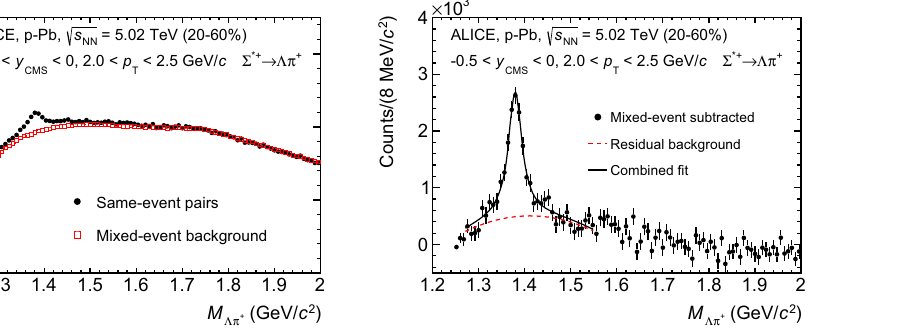
( Right ) the invariant mass distribution after subtraction of the mixed- event background. The solid curve represents the combined fit, while the dashed line describes the residual background